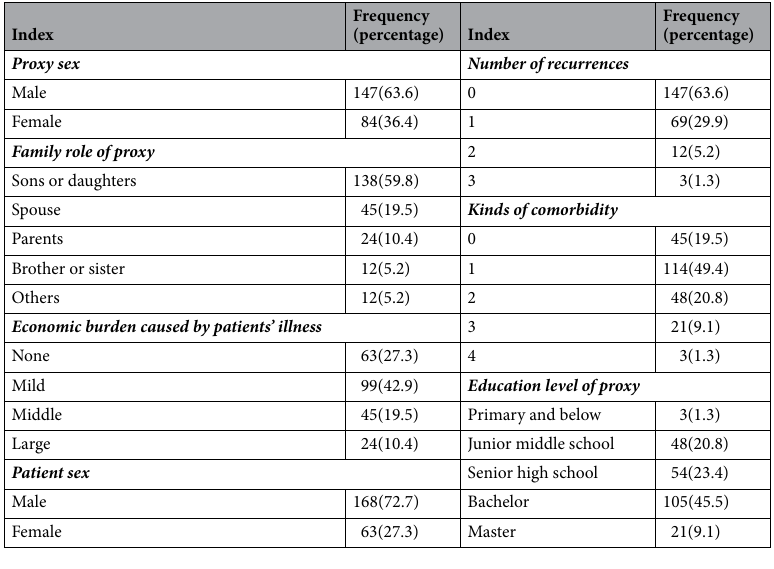
Table 1. General information of subjects (n = 231).